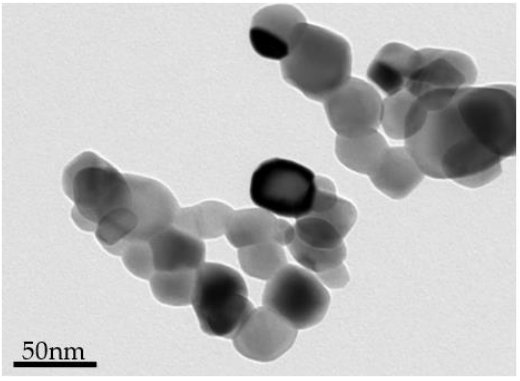
Figure 1. TEM image of ZrO 2 nanoparticles.